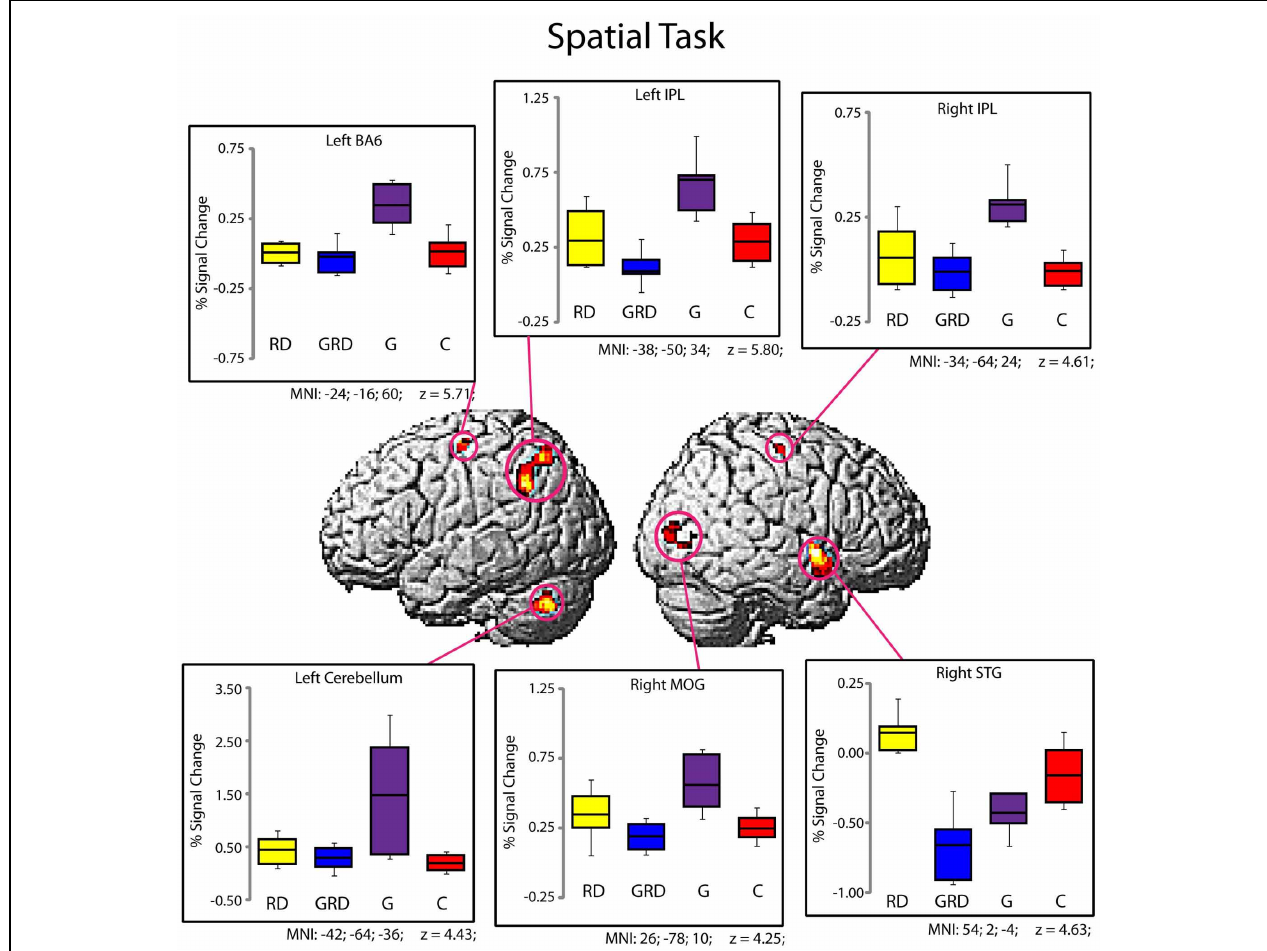
FIGURE 4 | Activity within the significant clusters from the main effect of Group for the Spatial Visualization tasks (also see Table 4). Significantly active clusters ( p < 0 . 001; cluster-size corrected) were surface rendered onto the SPM MNI template and represent regions that exhibited reliable differences in activation between the four groups. Boxplots represent percent signal change within the specific clusters for the four groups (RD: yellow, GRD: blue, G: purple, C: red). Horizontal lines within the boxplots